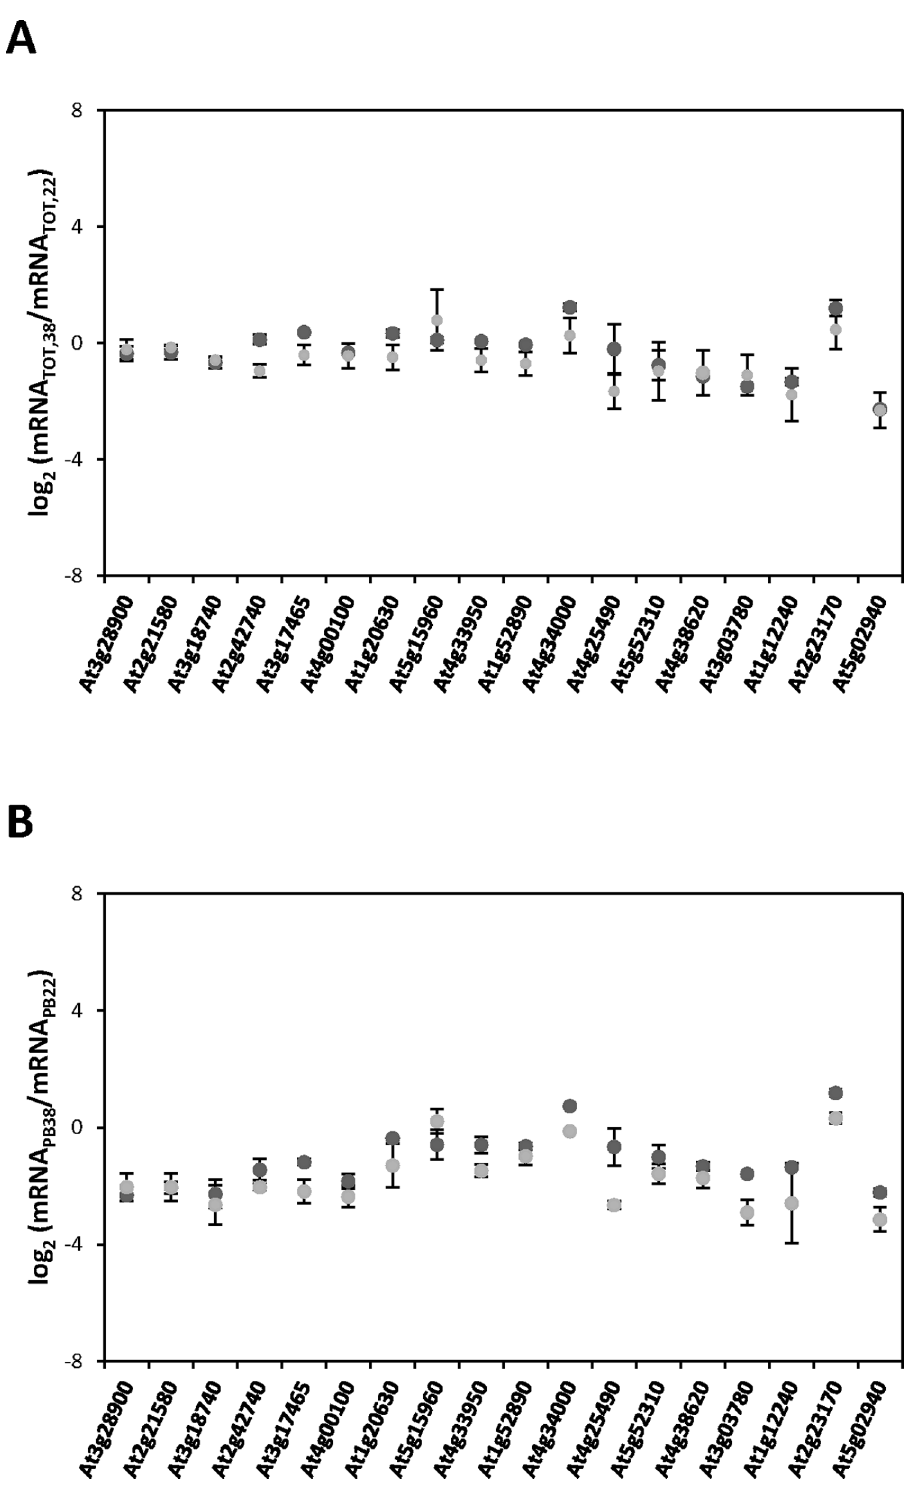
Figure 3. Confirmation of the heat-induced changes in transcriptome and translatome observed in the ATH-1 hybridization arrays by qRT–PCR. For a representative group of mRNAs, the log 2 changes in response to heat stress in steady-state levels ( A ) and in polysome-bound abundance ( B ) obtained from the ATH-1 hybridization arrays (dark-grey circles) were compared with the corresponding data obtained by the analysis of three independent biological replicates by qRT-PCR (light-grey circles). Mean (points) and standard deviations from the different replicates are shown.